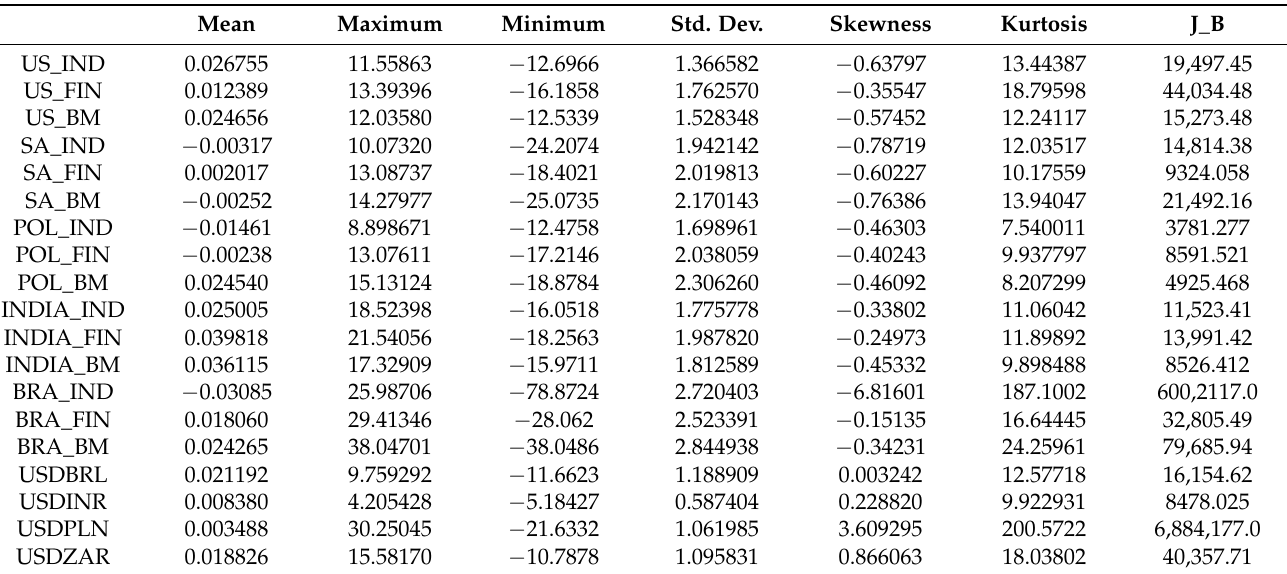
Table 1. Descriptive statistics of sectorial equity